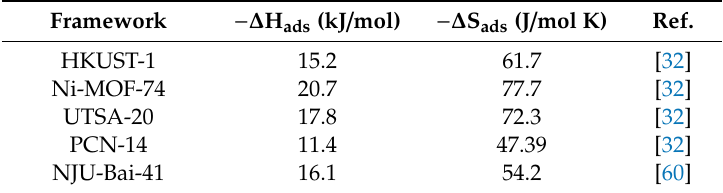
experiments determined using the Clausius-Clapeyron equation at constant loading.